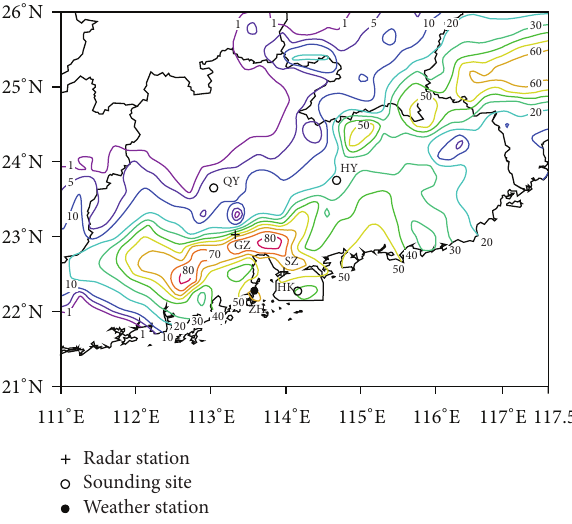
Figure 7: Accumulative precipitation contours at 1, 5, 10, 20, 30, 40, 50, 60, 70, and 80mm from weather stations between 0800 and 1400 LST 24 April